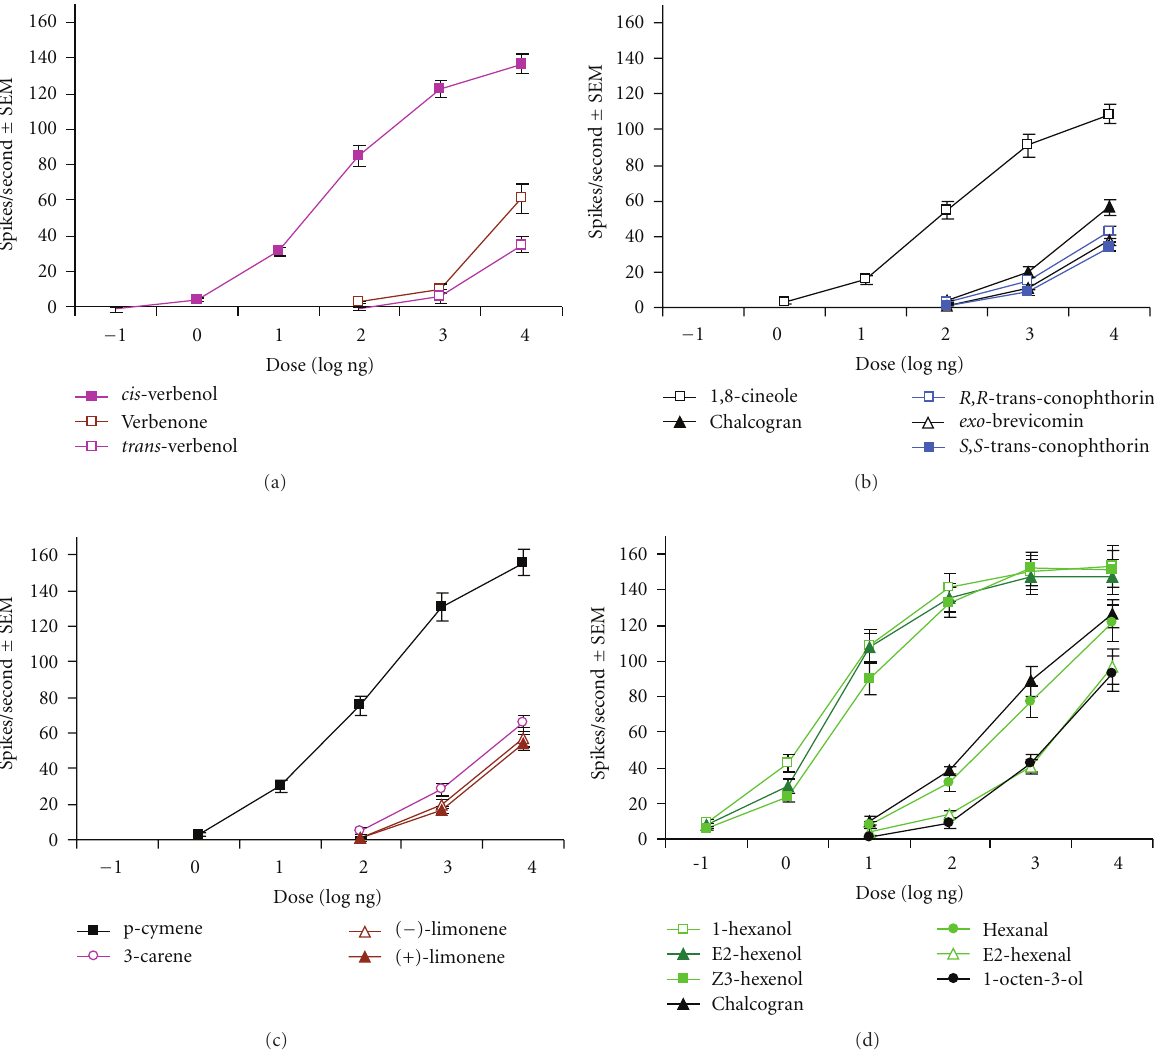
Figure 4: Dose-response curves from four receptor neuron classes of Ips typographus , demonstrating specific primary responses to (a) the pheromone component cis -verbenol, the spruce compounds (b) 1,8-cineole and (c) p-cymene. (d) Indiscriminate response to the three green leaf volatiles 1-hexanol, E 2-hexenol, and Z 3-hexenol (modified from [19], with permission from the